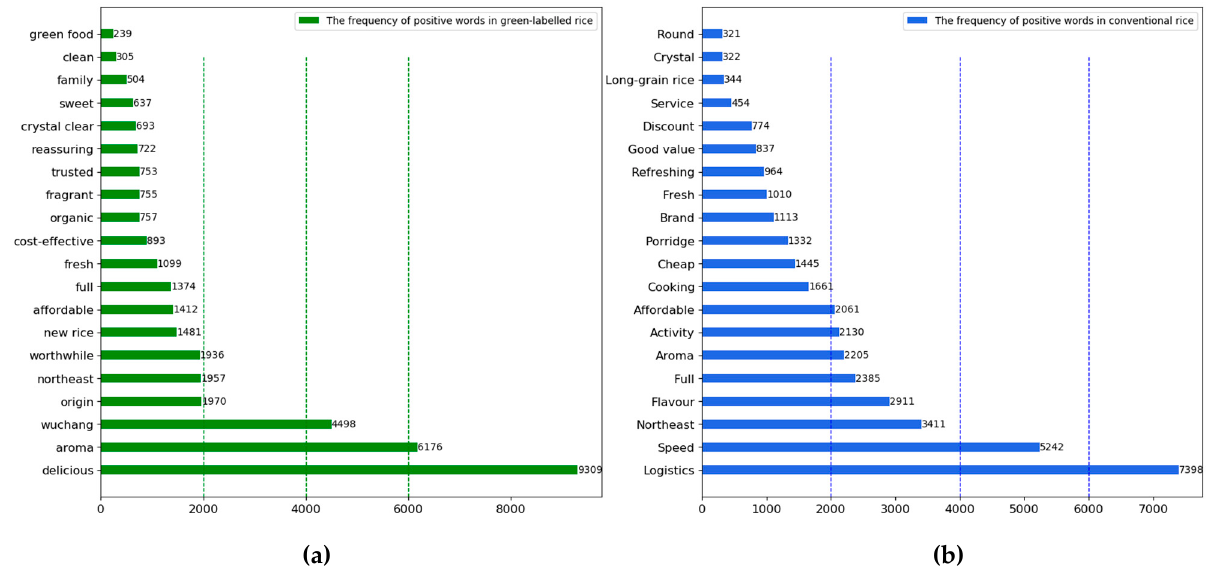
Figure 5. ( a ) Frequency of positive emotion-related words for green-labelled rice; ( b ) frequency of positive emotion-related words for conventional rice